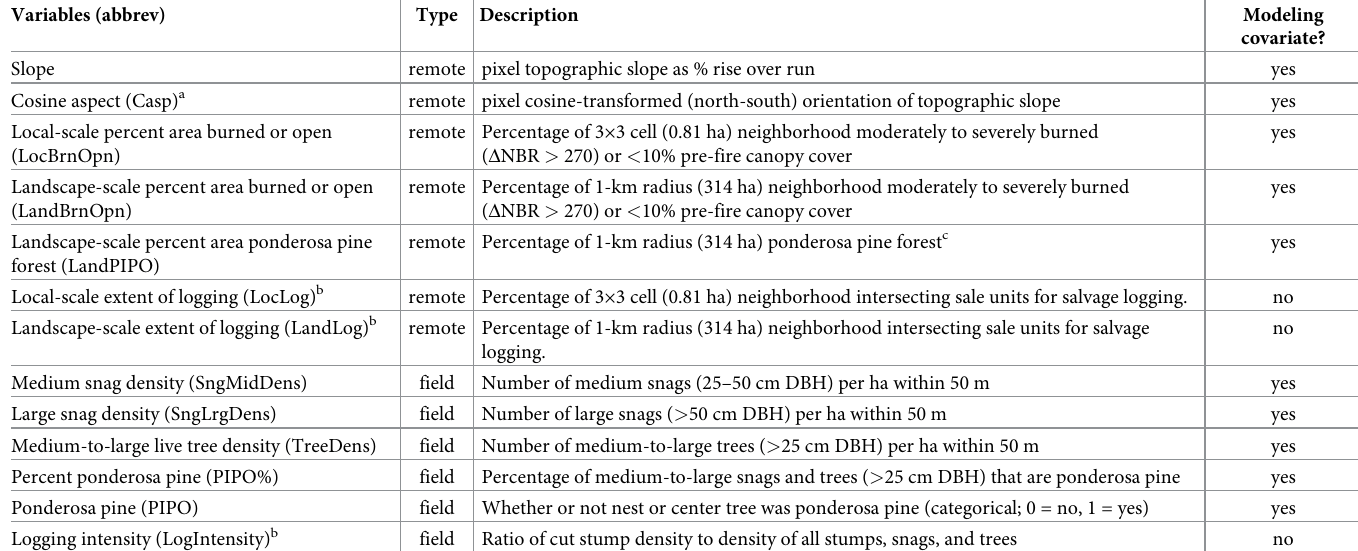
Table 2. Remotely sensed (remote) and field-collected (field) environmental variables measured at burned forest locations where habitat models were developed for nesting white-headed